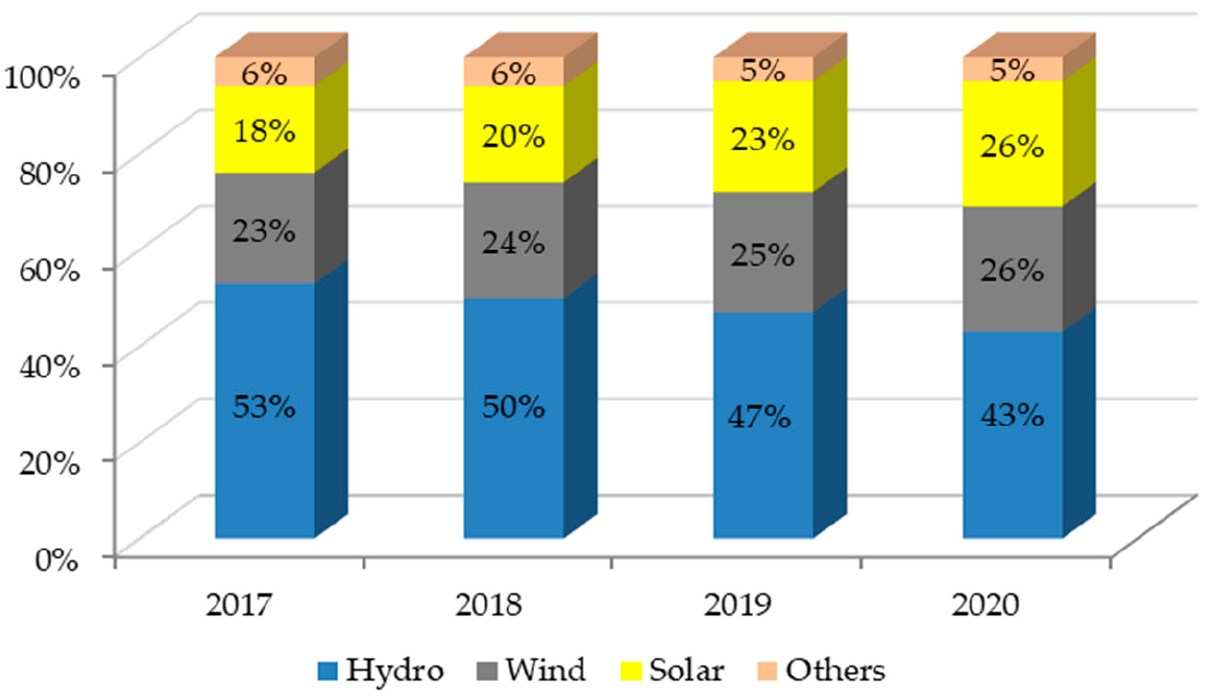
Figure 8. Renewable production capacity by energy sources (2017–2020). Source: Global Wind Report [32–35].